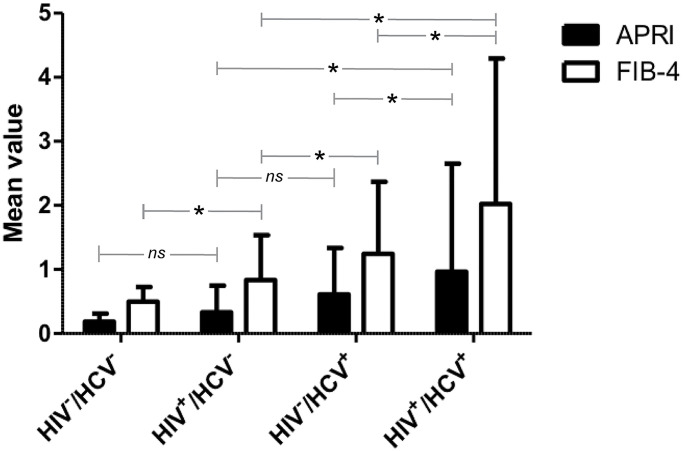
Mean liver fibrosis scores for each viral serotype.The mean APRI and FIB-4 scores at baseline visit + SD are shown for 1,858 women stratified by definitive viral serostatus. The number of patients (n) for each viral serostatus are indicated in Table 1. Pairwise comparisons of liver outcomes were performed for all viral-serotype group-comparisons within each liver metric. Apart from those comparisons labeled not significant (ns), all other comparisons within fibrosis index aside from those labeled as significant were also below the 0.05 p-value threshold.